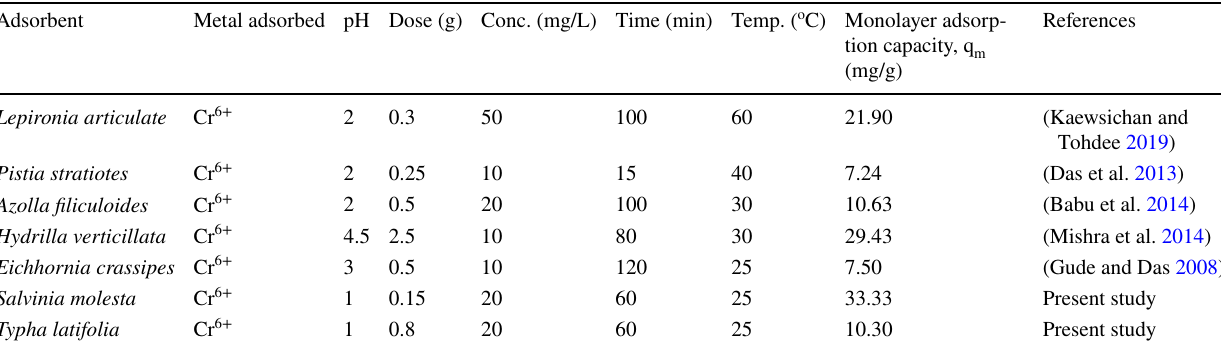
Table 4 Various aquatic plant adsorbents with their adsorption capacities and experimental conditions